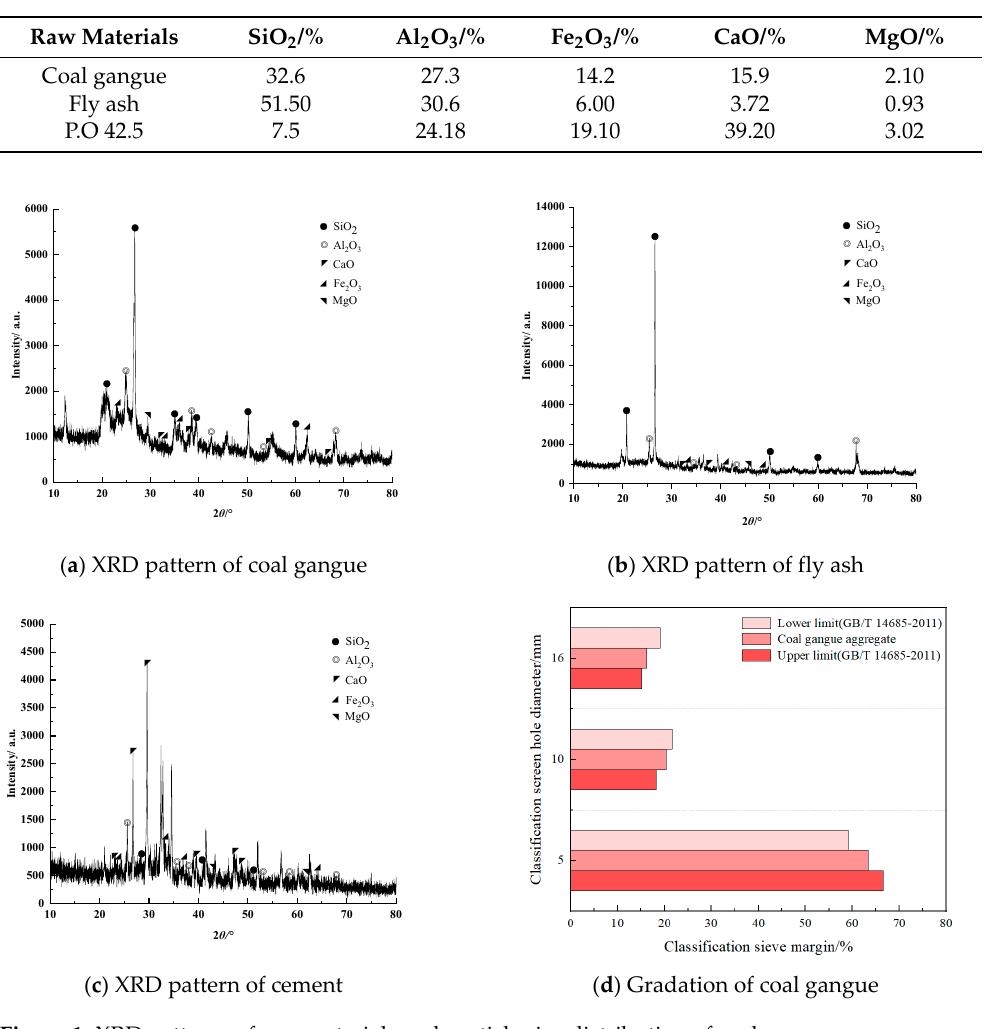
Table 1. Main components of the experimental raw materials.